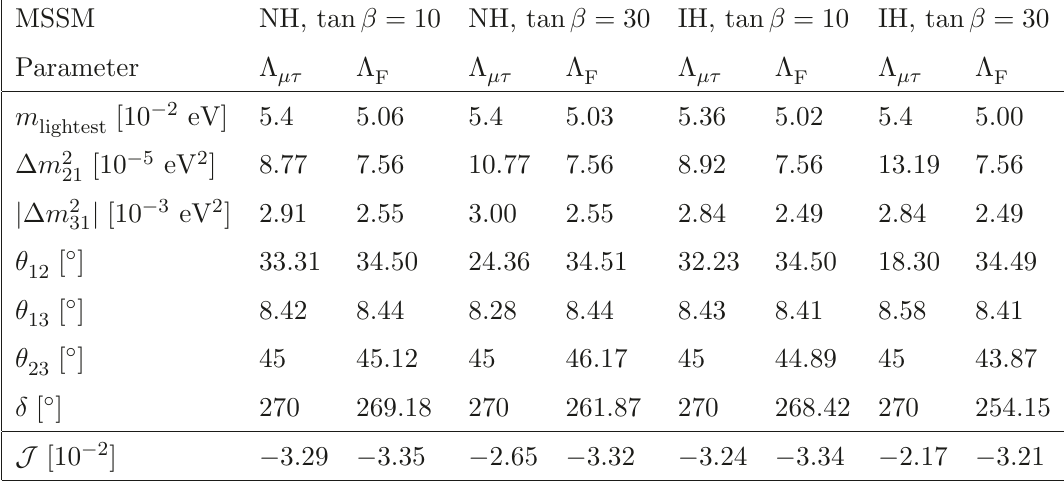
Table 1 . An illustration of the neutrino oscillation parameters at Λ tan β = 10 or 30, where both NH and IH cases are considered.